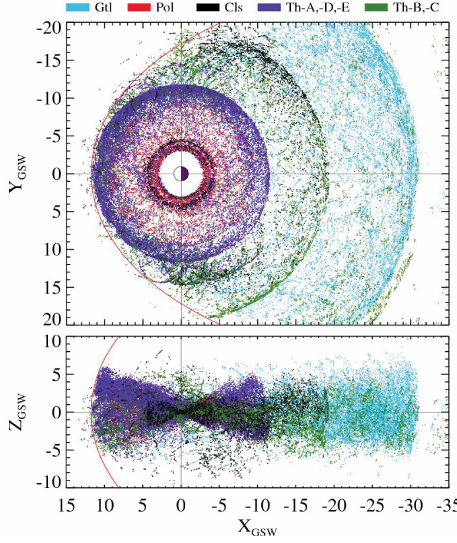
Figure 1. Distribution of data points in the crossings set, projected onto GSW equatorial (top) and noon–midnight (bottom)